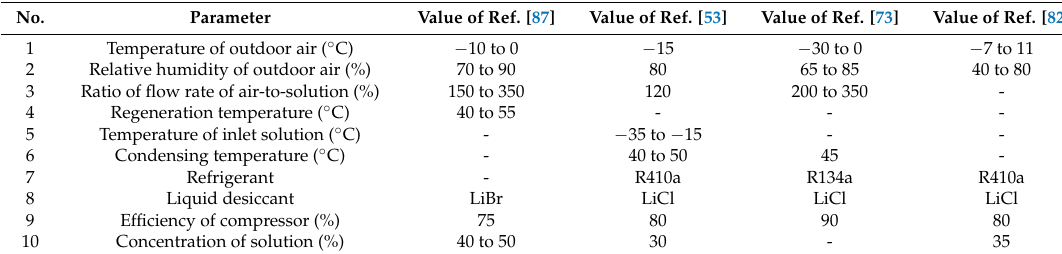
Table 7. Values for the analyzed parameters in different studies.